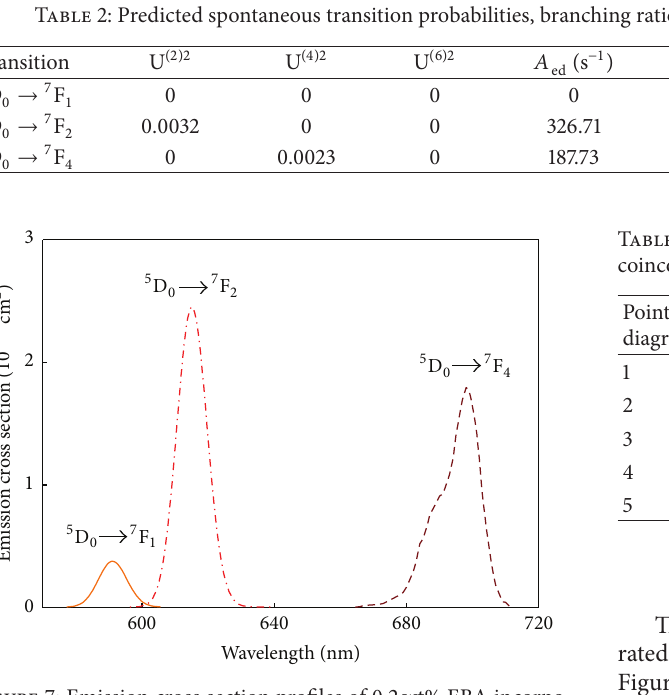
with the concentration of TBA varying from 0 to 1.4